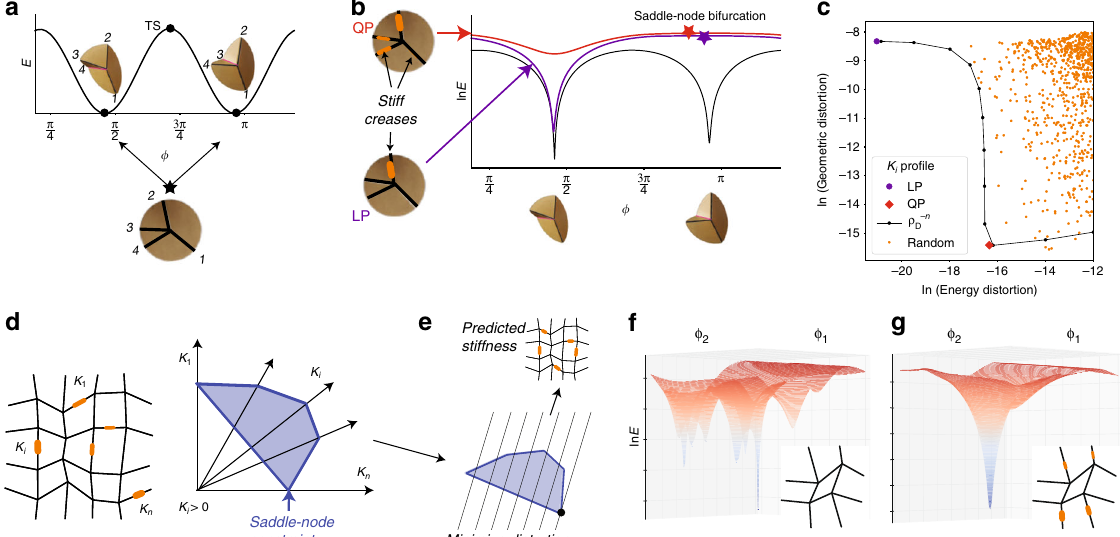
Fig. 2 Heterogeneous stiff creases can simplify the landscape of self-folding sheets near the fl at state. a An origami 4-vertex has a choice between two distinct folding modes at the fl at state ( ϕ — null space angle variable, see Supplementary Note 2). b Stiff creases completely eliminates a chosen mode by combining it with a nearby transition state (TS) in a saddle-node bifurcation (thickness of orange strip indicates stiffness.) c Trade-off: stiff creases distort the desired mode while eliminating undesired modes. Stiffness pro fi les that minimize energy distortion (e.g., the linear programming (LP) method) cause large geometric distortion and vice versa (e.g., the quadratic programming (QP) method). d The exponentially many misfolding modes of large sheets are all eliminated if the stiffness pro fi le κ i satis fi es a linear constraint, shown here as a simplex. e We can minimize distortion (energy or geometry) of the desired mode by optimizing crease stiffness on this simplex. f , g All but one chosen minimum in a pattern ’ s energy landscape (at small overall folding) can be eliminated by stiff creases predicted by the procedure in ( e